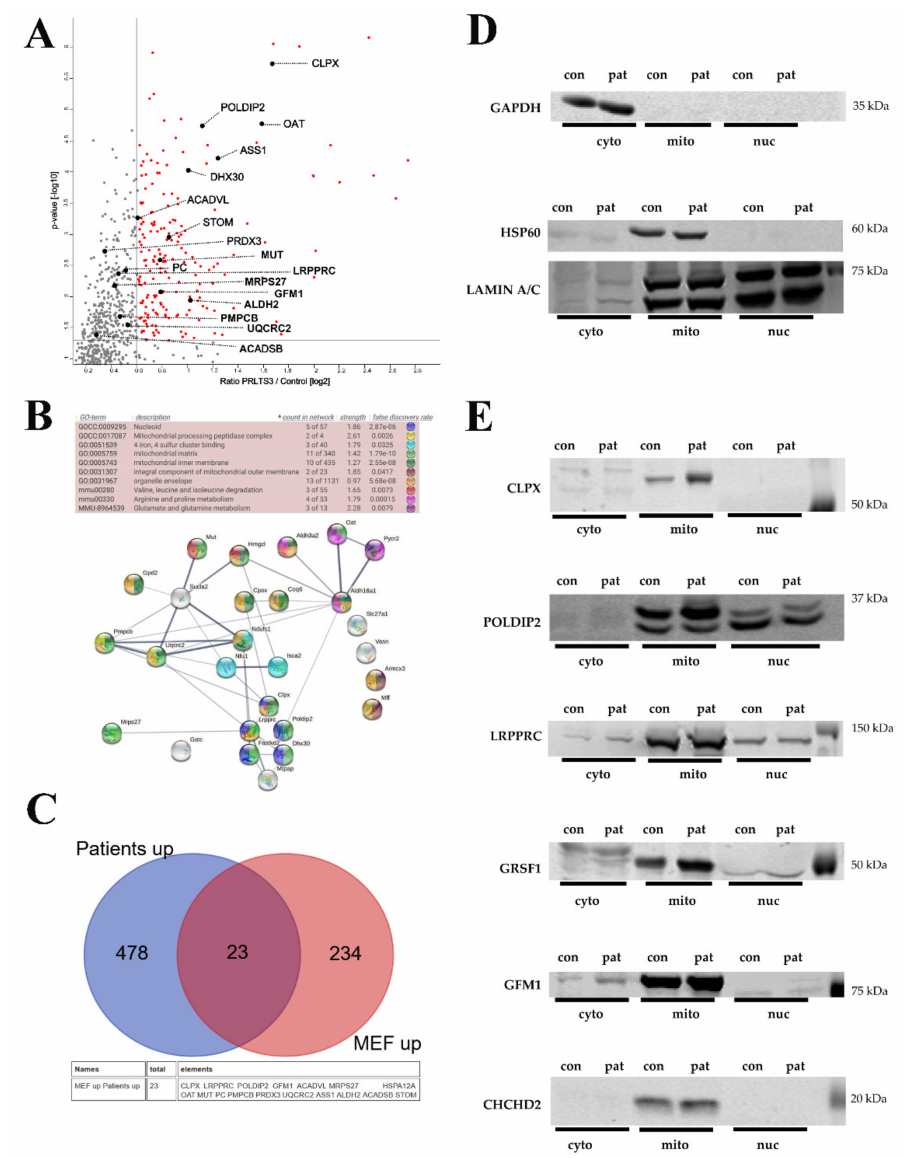
Figure 4. ( A ) Analysis of both PRLTS3 patients’ (in triplicates) versus 7 healthy controls’ skin fibroblast proteome profiles in volcano plots, highlighting the accumulated proteins in mitochondria. The significance threshold at 1.3 on the Y -axis corresponds to the p -value 0.05, and the X -axis shows the traditional cut-off at 1.5-fold effects, although genetic evidence has demonstrated a neurodegenerative process at old age to be triggered by a lower gain-of-function, such as 1.3-fold dosage of alpha-synuclein. ( B ) Analysis of the differences between both patients in a STRING interaction diagram, focused on mitochondrial proteins with significant accumulation in ClpP- mutant patient skin fibroblast global proteome, which showed 1.2-fold stronger change in the severely affected patient 58955 than in the milder patient 0006. ( C ) Comparison of all accumulations with nominal significance in both PRLTS3 fibroblasts that showed consistency with nominal significant accumulations in ClpP-null MEFs, using a Venn diagram. A total of 23 effects were consistent between species, among which all mitochondrial proteins are listed below, employing their gene symbol. ( D ) Analyses of protein abundance in fibroblasts from a human control (red128) and the patient with stronger fold changes (58955), controlling the subcellular fractionation purity and loading by GAPDH (cytosolic marker), HSP60 (mitochondrial), or LAMIN A/C (nuclear) abundance. ( E ) Quantitative immunoblots for CLPX and its protein interactors confirmed their accumulation (e.g., 2.33-fold for ClpX normalized to HSP60) to be restricted to